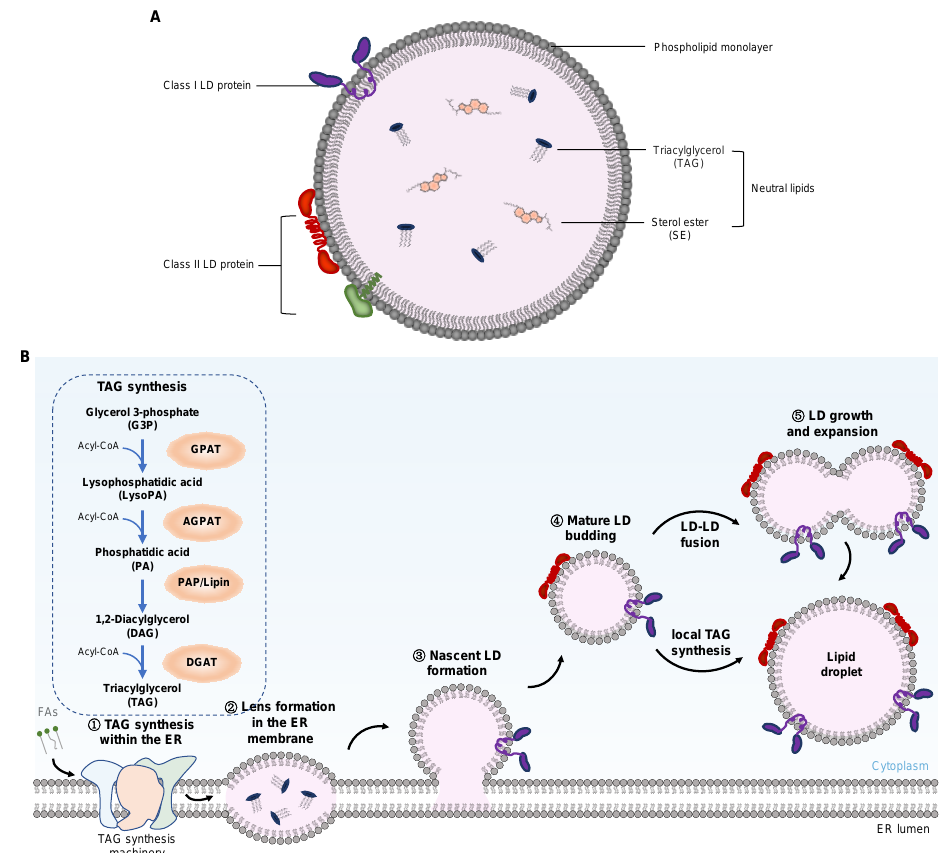
Figure 2. Schematic representation of the LD structure and a model of the key steps in LD biogenesis. ( A ) LD is composed of a core of neutral lipids, such as TAGs and SEs, surrounded by a phospholipid monolayer. LD surface-bound proteins are classified into two groups. Class I LD proteins, such as GPAT2, mostly contain a hydrophobic hairpin that is associated with the lipid monolayer; Class II LD proteins, such as perilipins, are inserted into the LD from the cytosol via amphipathic helices or other short hydrophobic domains. ( B ) Five essential steps are involved in LD formation, growth, and expansion. Abbreviations: LD, lipid droplet; TAG, triacylglycerol; SE, sterol esters; FAs, fatty acids; Acyl-CoA, acyl-coenzyme A; ER, endoplasmic reticulum; GPAT, glycerol-3-phosphate acyltransferase; AGPAT, acyl-glycerol-3-phosphate acyltransferase; PAP, phosphatidate phosphatase; DGAT, diacylglycerol